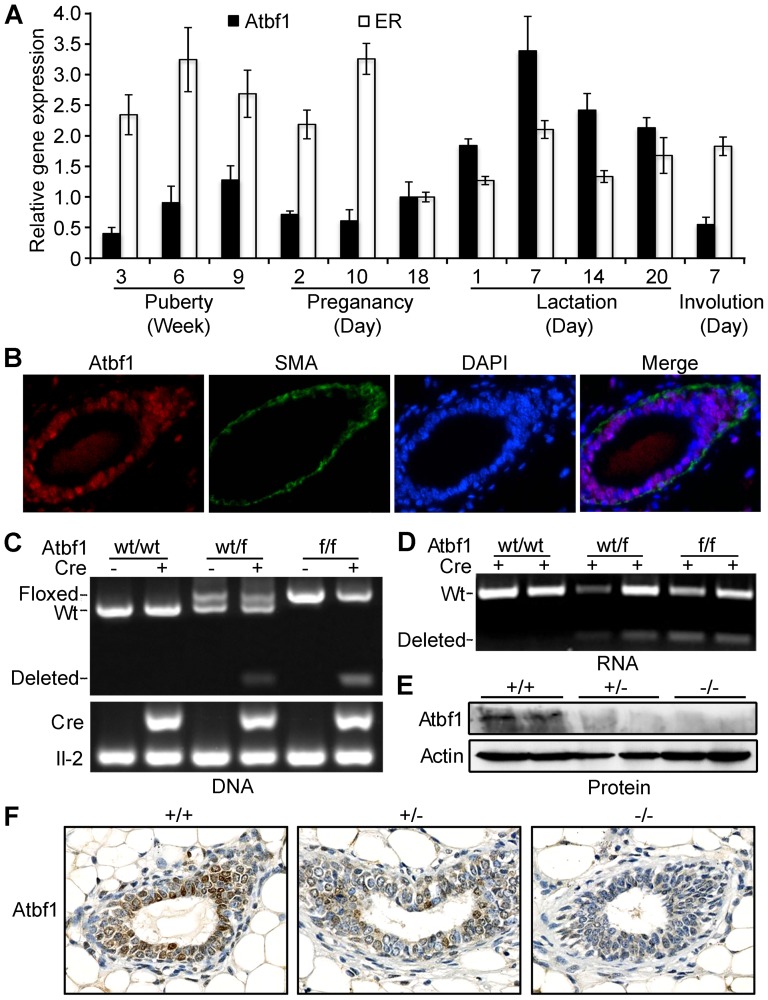
Validation of mammary epithelial cell-specific deletion of Atbf1 in mice.(A) Increased expression of Atbf1 mRNA in mammary glands of C57BL/6J female mice during puberty and the first week of lactation, as measured by real time RT-PCR. Three mice were used for each time point. Expression of ER, which changes at different stages, was used as a positive control. P values for comparisons between puberty and lactation, between pregnancy and lactation, and between puberty and pregnancy are <0.005, <0.005, and 0.962, respectively. (B) Double IF staining of Atbf1 (red) and SMA (green) shows the expression and localization of Atbf1 in mouse mammary gland. (C) Deletion of Atbf1 genomic DNA upon the expression of Cre in mammary tissues, as detected by PCR. The upper panel shows the wild-type Atbf1 allele (Wt), floxed allele without deletion (Floxed), and the allele with Cre-mediated deletion (Deleted). The lower panel shows the presence of the Cre gene in a mouse, with the interleukin-2 gene (Il-2) as a PCR control. Genotypes and Cre status are indicated at the top. (D) Detection of truncated Atbf1 mRNA in mouse tissues expressing the Cre gene under the MMTV promoter. All mice are positive for MMTV-Cre. “+” and “−” indicate wild-type (Wt) and deleted Atbf1 mRNA respectively. Each lane represents one mouse and two mice were used for each genotype. (E, F) Reduced Atbf1 protein expression by Cre-mediated deletion, as detected by western blotting (E) and immunohistochemical staining (F) with antibody against ATBF1. Thoracic mammary glands from mice with wild-type (+/+), heterozygous (+/−) and homozygous (−/−) Atbf1 were used in these analyses.